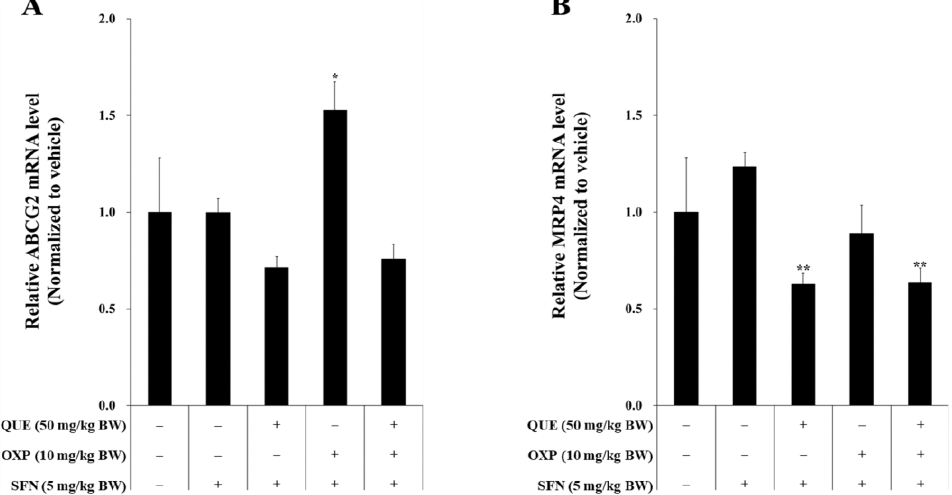
Figure 9. A combination of QUE, SFN, and OXP downregulated the transcriptional expression of the ABCG2 and MRP4 genes in xenograft tumors. The mRNA expression levels of the drug-resistant genes ABCG2 ( A ) and MRP4 ( B ) in HCT116 xenografts were measured using RT-qPCR. Error bars represent means ± SD ( n = 4). A significant difference is indicated by asterisks compared with vehicle and SFN (*, p < 0.05, **, p < 0.01, Student’s unpaired t -test).